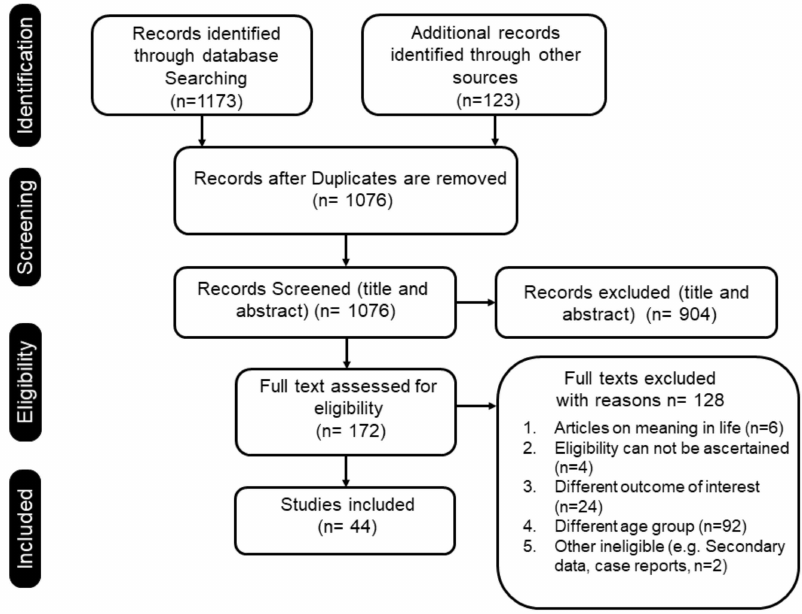
Figure 1. Database search and number of included